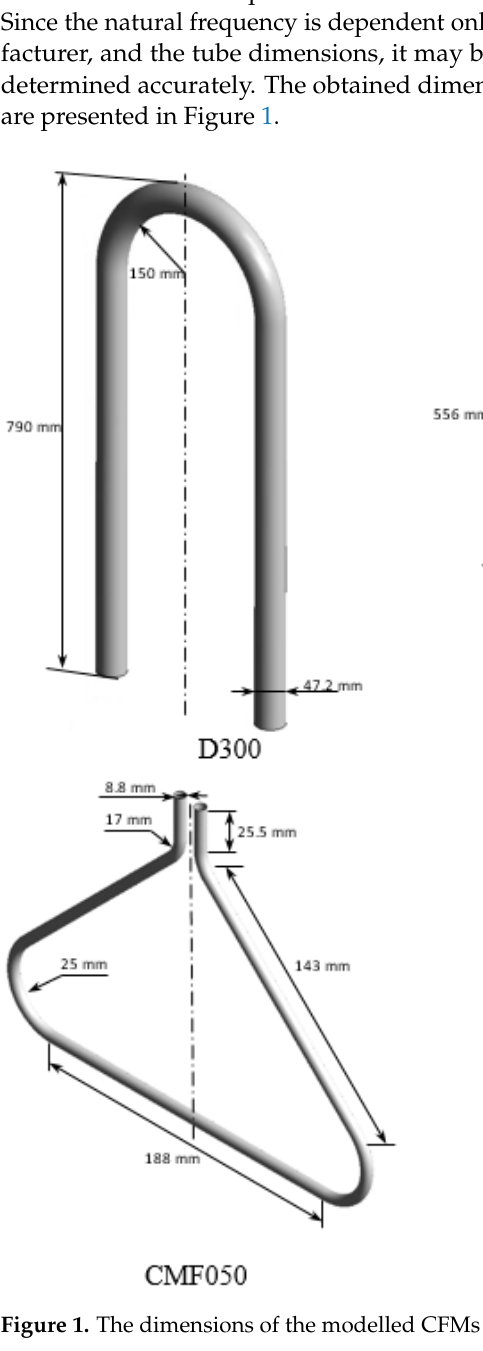
Figure 1. The dimensions of the modelled CFMs tubes.